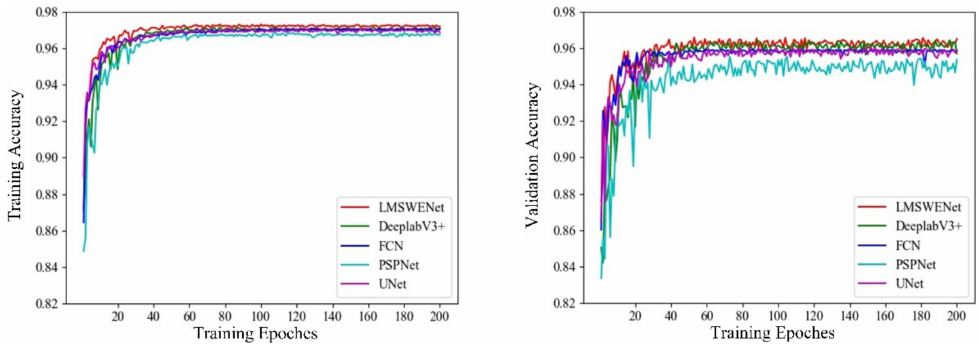
Figure 7. The accuracy curves of training and validation.